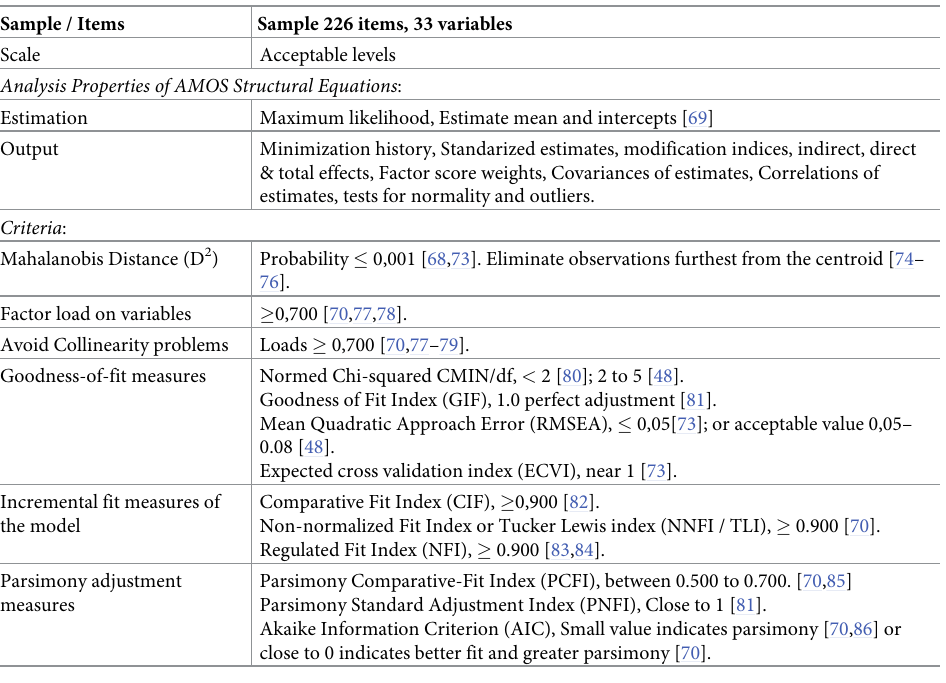
Table 8. Criteria and analysis